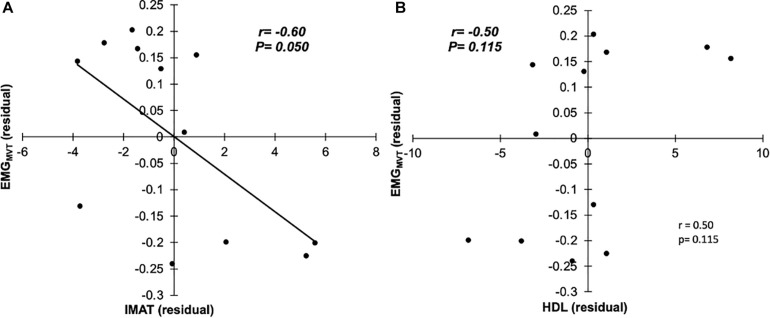
Partial correlations with SUBFAT as covariate, between EMGMVT and IMAT (A), and HDL (B; n = 12).